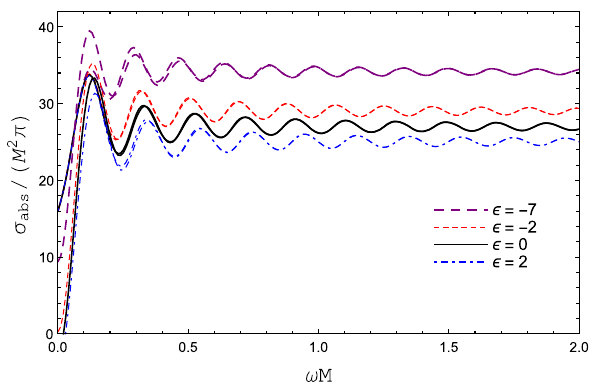
Fig. 14 Comparison of the sinc approximation with the numerical solutionforfourvaluesofthedeformationparameter( ε = − 7, ε = − 2, ε = 0, and ε = 2)